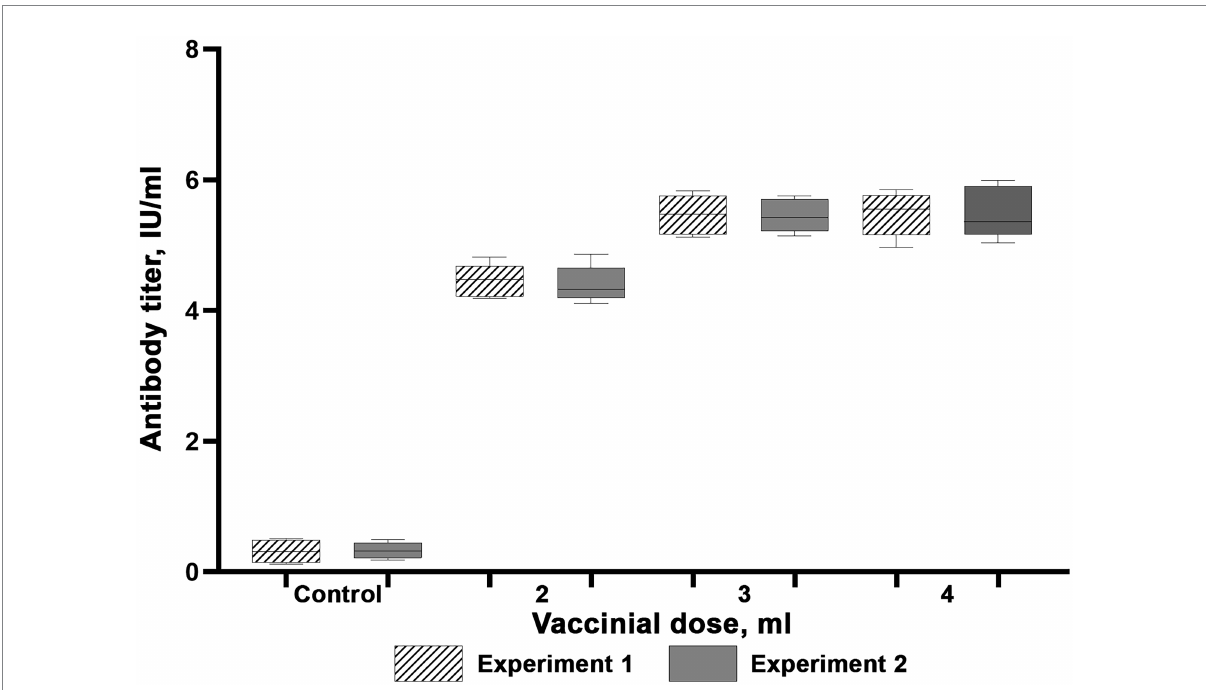
FIGURE 5 Virus-neutralizing activity of blood serum of reindeer once immunized with the Lyophilized vaccine. Two independent experiments (Experiment 1 and Experiment 2). In each experiment, 15 animals were vaccinated (5 animals per each dose). Four unvaccinated animals were used as a control group. Reindeer blood serum were collected 21 days after administration. Maximum and minimum titres are illustrated with whisker caps, interquartile range with a box with the median denoted by a horizontal